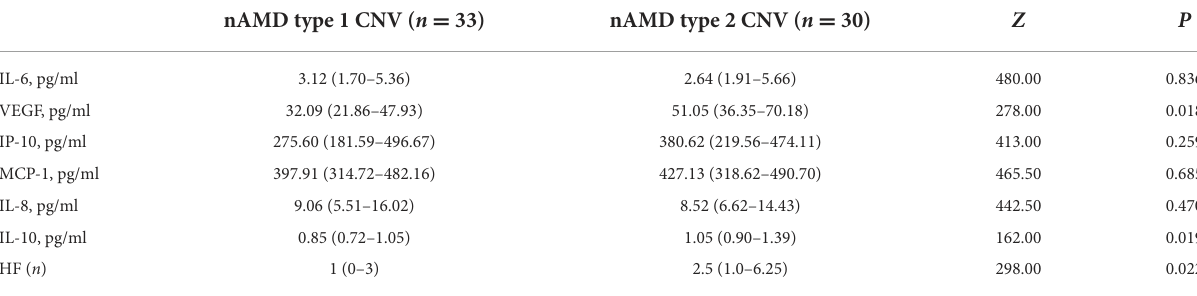
TABLE 4 Baseline differences in cytokine levels and HF between type 1 CNV and type 2 CNV in